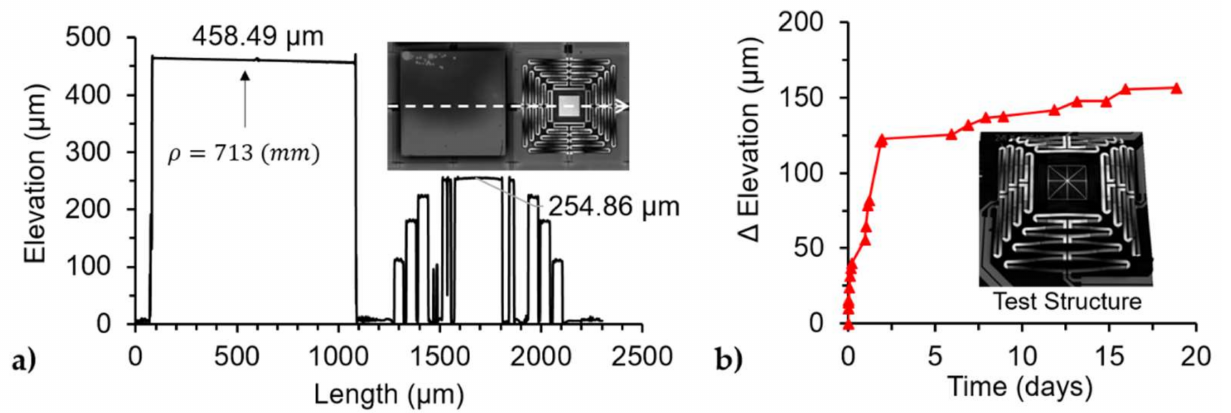
Figure 6. 3D Confocal Microscope measurements: ( a ) Initial elevation of the mirror bonded and undercarriage device moments after release with an inset of the top view of the devices, ( b ) the change in test structure elevation over time with an inset of a composite image from the confocal microscope of the test structure. After the device was fabricated and released the elevation was tracked over a period of time without any external stimuli, and a temporal drift was